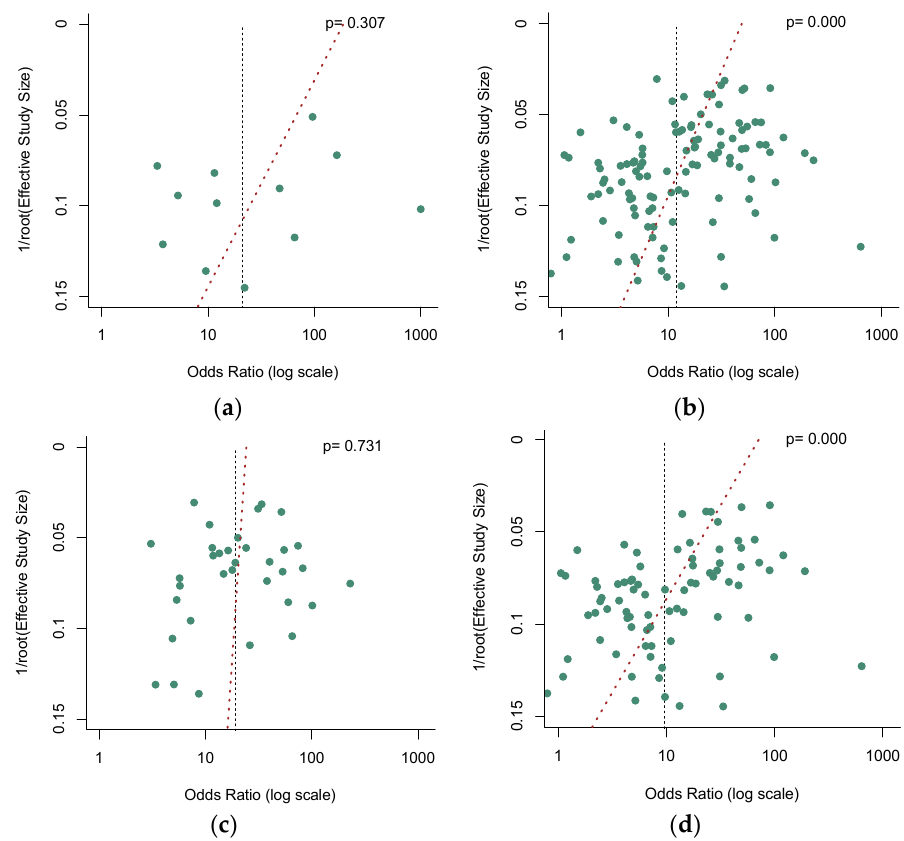
Figure 7. Funnel plots to evaluate the publication bias for ( a ) the quantitative detection subgroup; ( b ) the qualitative detection subgroup; ( c ) the SEPT-9 methylation detection subgroup; ( d ) the non- SEPT-9 methylation detection subgroup.